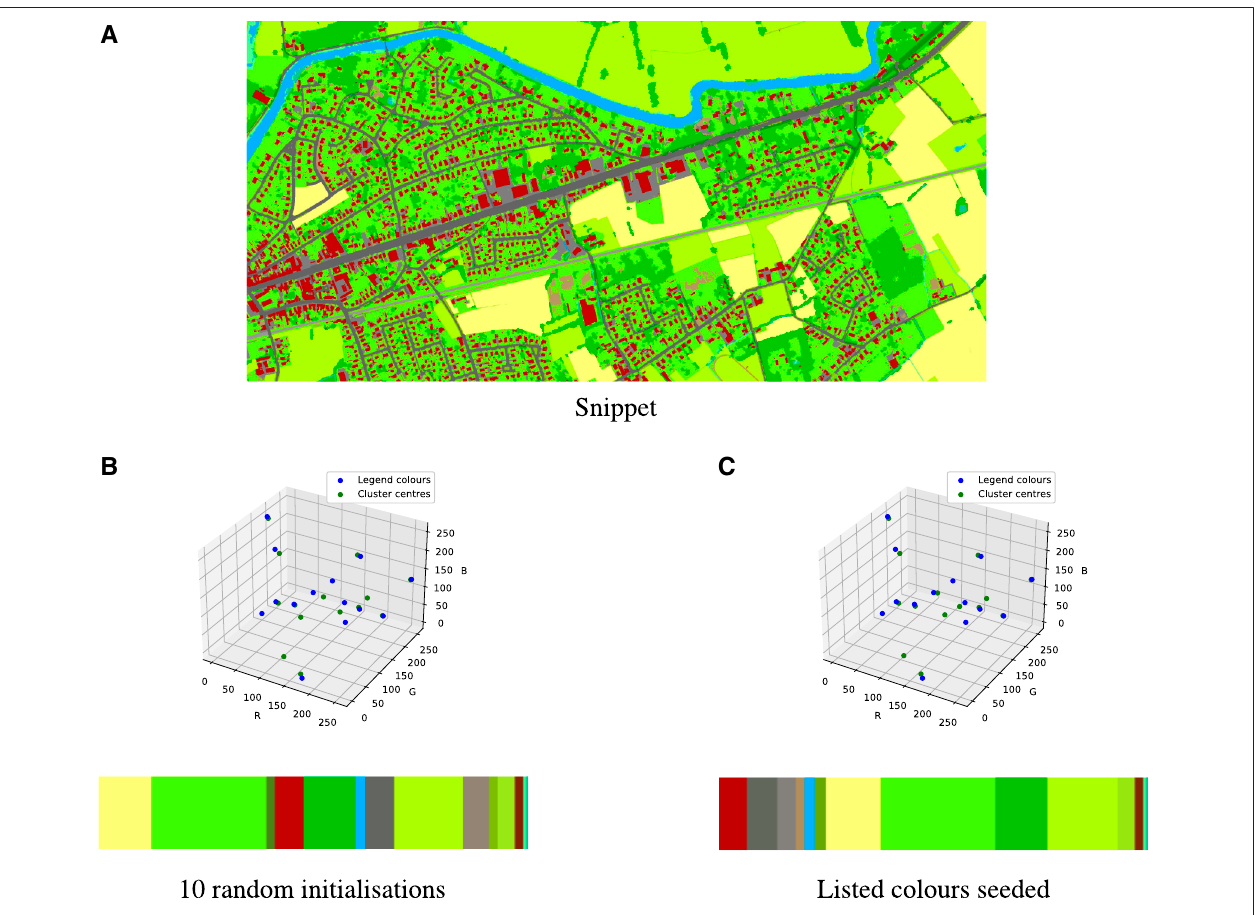
FIGURE 10 | Effect of seeding the original colour centres. (A) Snippet, (B) 10 random initialisations, (C) Listed colours